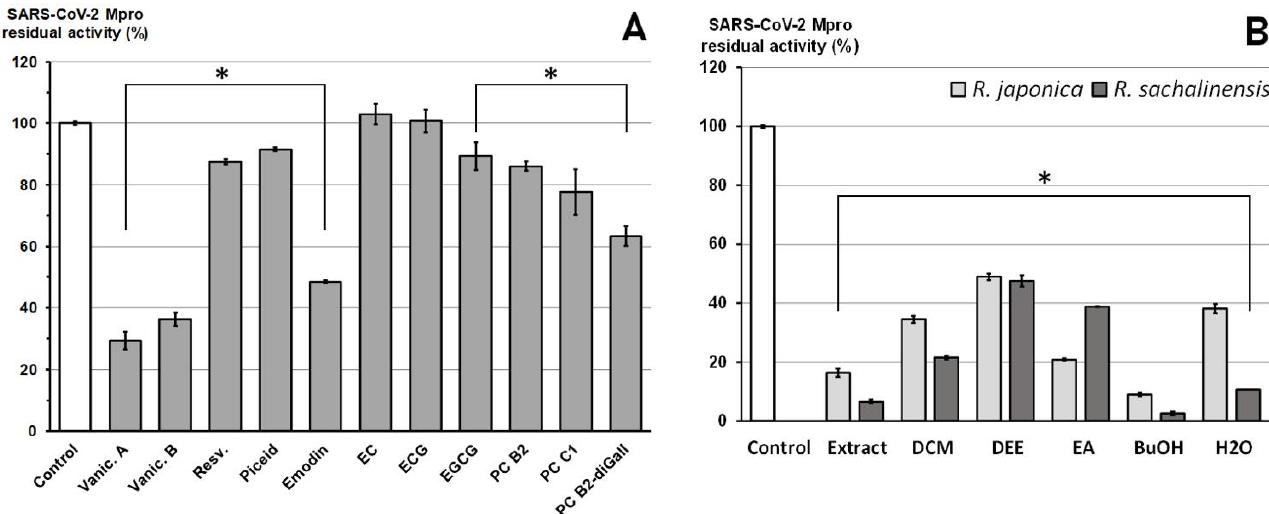
Figure 4. Screening for SARS-CoV-2 Mpro inhibitors. Inhibitors (I), with final concentration equal to 100 µM for individual compounds ( A ) and 50 µg/mL for extracts and fractions ( B ) The results were presented as SARS-CoV-2 Mpro residual activity (%), in relation to control without inhibitor. Error bars shown in this figure are means ± SD for n ≥ 3. * Statistically significant at p ≤ 0.05 compared to control. Abbreviations: Vanic. — vanicoside, Resv. — resveratrol, EC-epicatechin, ECG —